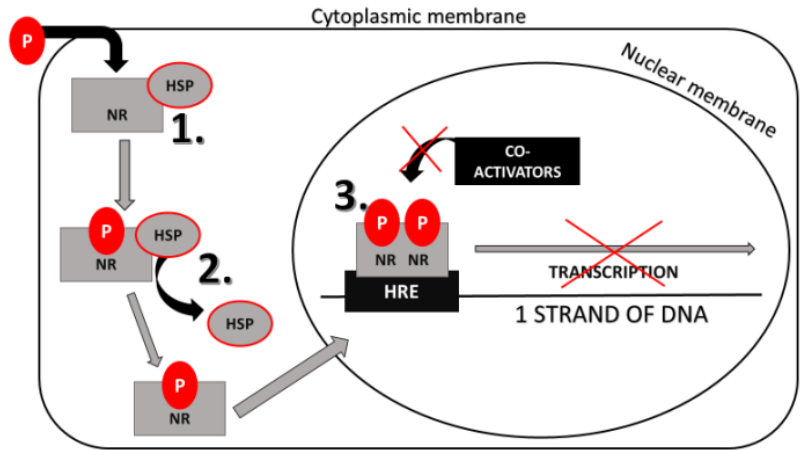
Figure 2. Phthalate action on nuclear receptors: this figure shows another form of antagonism when P prevents the NR from forming the correct conformation to activate the co-activators of transcription and thereby inhibit transcription. 1. P binds to the NR; 2. HSPs dissociate from the P-NR complex; 3. Co-activators cannot bind to the P-NR complex and therefore inhibit transcription; HRE-hormone response elements; HSP-chaperones, NR-nuclear receptor, P-phthalate. Table 5. Estrogenic/anti-estrogenic and androgenic/anti-androgenic affinity of the selected phthalates [237]. Estrogenic Anti-Estrogenic Androgenic Anti-Androgenic Affinity Affinity Affinity